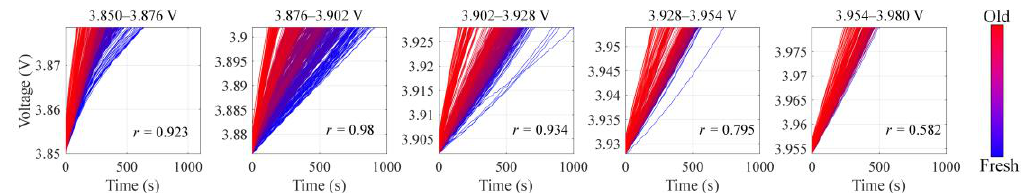
Figure 7. Variation of voltage curves in different sections of CALCE.